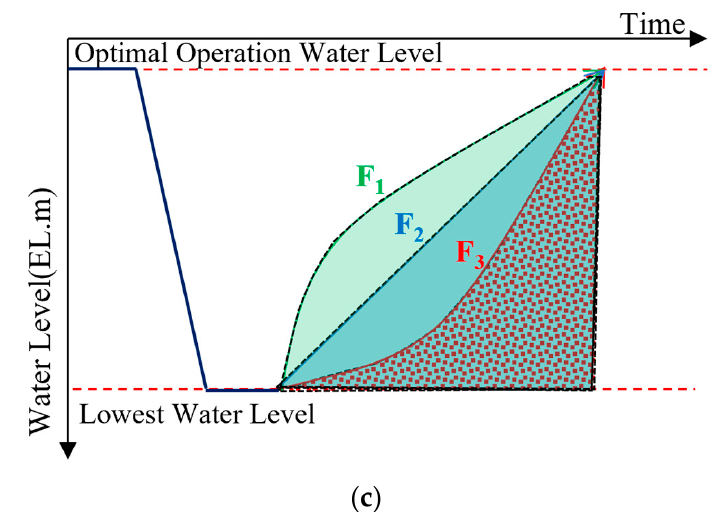
Figure 1. Resilience of Hydroelectric Dam. ( a ) Concept of Resilience; ( b ) Resilience with recovery time; ( c ) Resilience with recovery function.